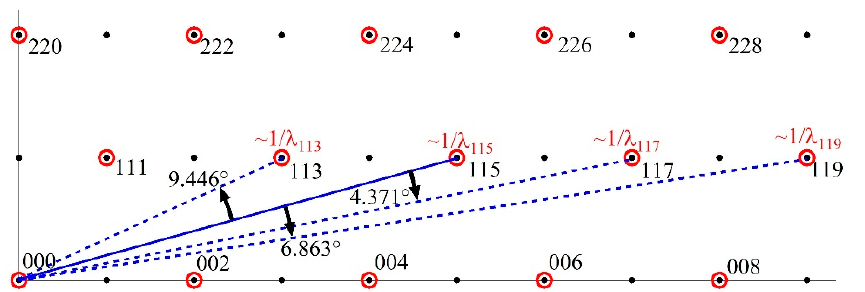
Figure 2. Reciprocal lattice with zone axis [ 110] of a single crystal germanium (115) cut, employed as a monochromator for WOMBAT, where the black points with red circles stand for the basic primary reflections and those without red circles designate forbidden reflections: when the take-off angle 2 θ M = 90 ◦ was set, the obtained incident beam wavevector and wavelength were k 115 = 4.0811 Å − 1 and λ 115 = 1.5396 Å; when the crystal was rotated relatively along its zone axis about 9.446 ◦ , − 4.371 ◦